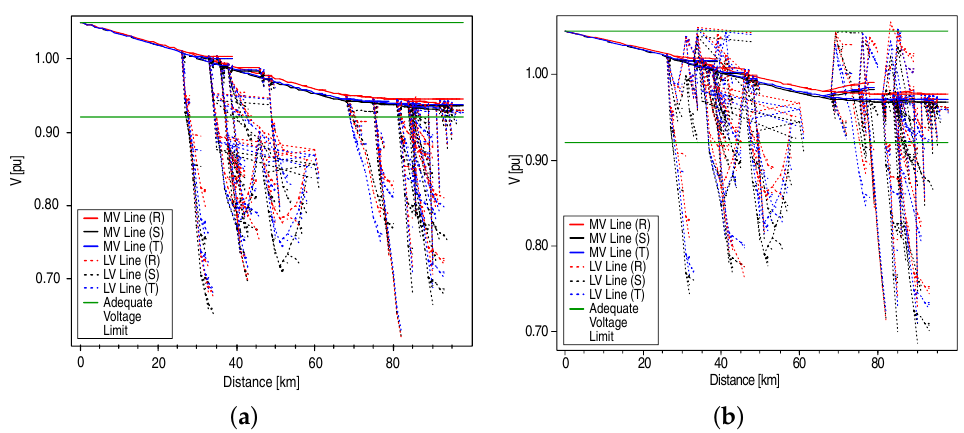
Figure 33. Result of optimization of variables pos , pot , and qtd with bars constraint: ( a ) voltage profile before allocations and ( b ) voltage profile after